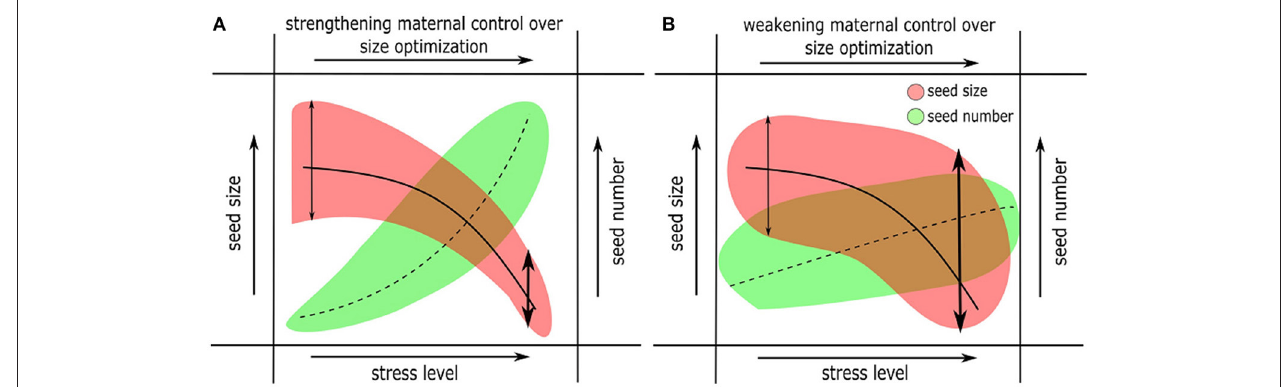
FIGURE 4 | Changes in offspring size and numbers in response to changes in environmental factors (sub- optimal or stressful conditions). Two alternative scenarios are represented. (A) Strengthening maternal control (vis-à-vis zygotic controls) over offspring size optimization, and (B) Weakening maternal control over size optimization. Scenario (A) combines the hypotheses presented in the models in Figures 1B,C (derived from the classical Smith-Fretwell model), where resource limitation causes strengthening of maternal controls over size optimization. Scenario (B) means a more complicated interaction between maternal, zygotic genetic controls over size optimization and their environment. The response of offspring number in (A) is expected to increase and in (B) it is less predictable under harsh